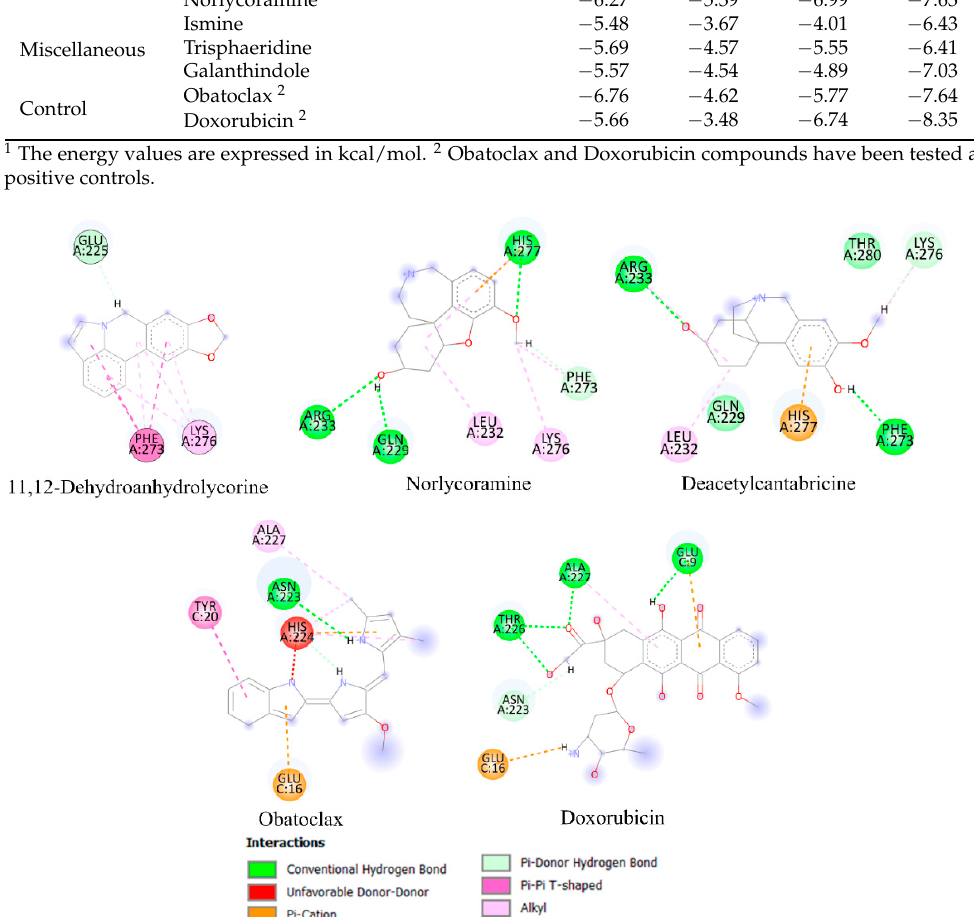
Figure 5. Principal interactions located by the molecular docking experiments between the ligands 11,12-dehydroanhydrolycorine, deacetylcantabricine, norlycoramine, and powelline with Bcl-xL protein.